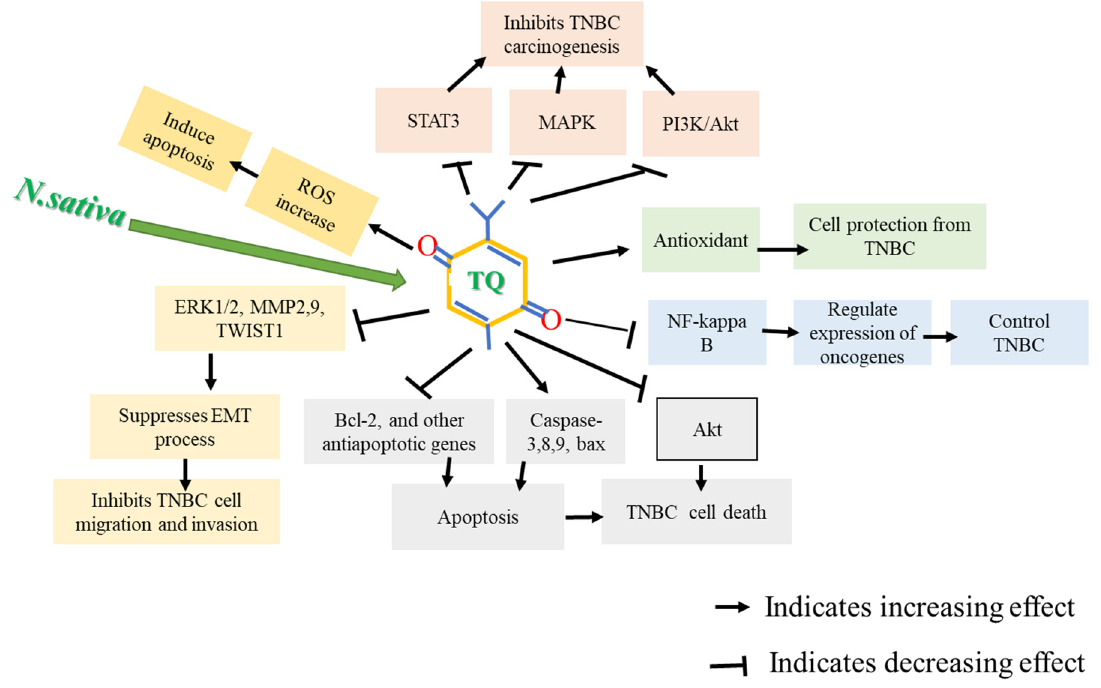
Figure 2. Possible anti-cancer mechanism of thymoquinone (TQ). TQ caused apoptosis in TNBC cells by inducing apoptotic genes, downregulating anti-apoptotic genes, and generating reactive oxygen species (ROS). TQ also suppresses Akt activation, deactivates Nf-kB, and increases antioxidant enzymes, inhibiting TNBC carcinogenesis.